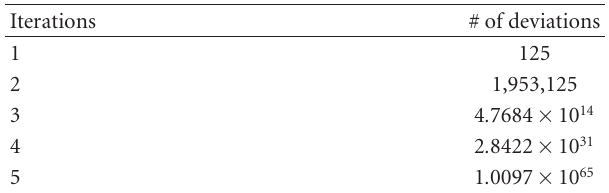
Table 2: Number of deviations at iterations 1–5 for a (3,6)-regular LDPC